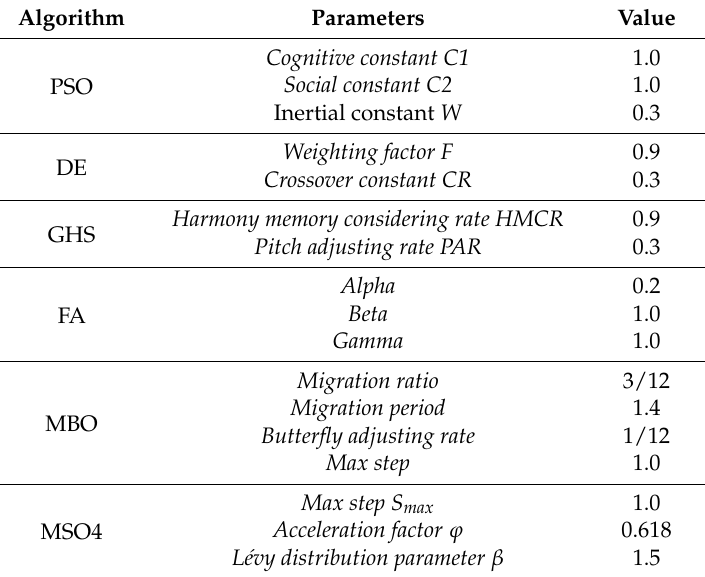
Table 7. The parameter settings of six algorithms on